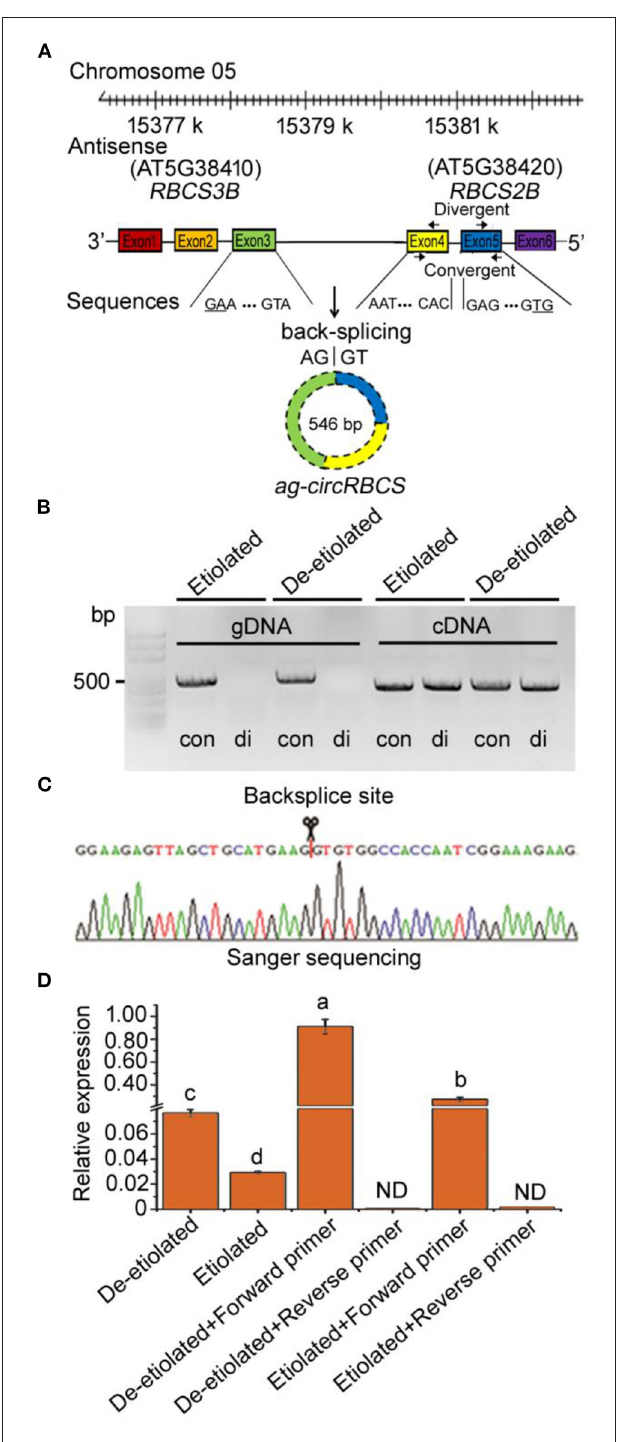
FIGURE 1 | Identification of circular RNA from Arabidopsis seedlings. (A) ag-circRBCS is encoded by three exonic regions, exon3 of RBCS3B and exon4, 5 of RBCS2B. (B) Divergent primers successfully amplified circular RNAs in cDNA but failed in genomic DNA. Convergent primers worked on both cDNA and genomic DNA. con, convergent primers; di, divergent primers. (C) Sanger sequencing further confirmed head-to-tail back-splicing. (D) The